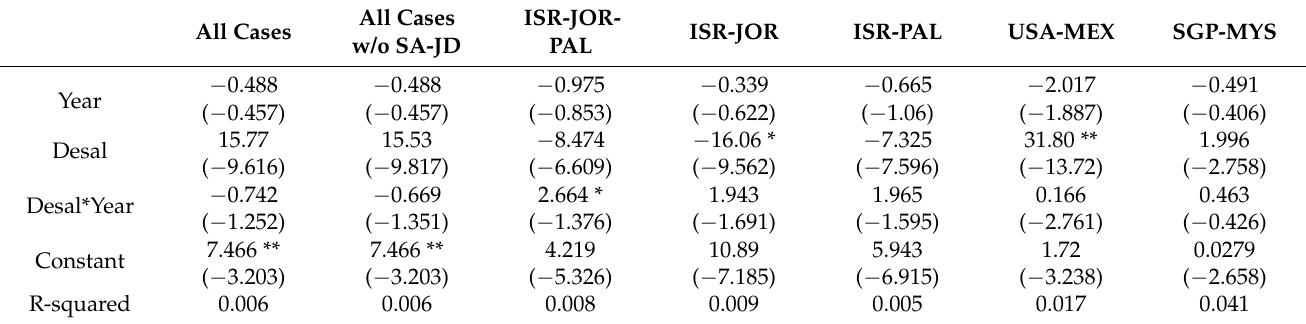
Table 6. Regressions using the +/ − 15 Years